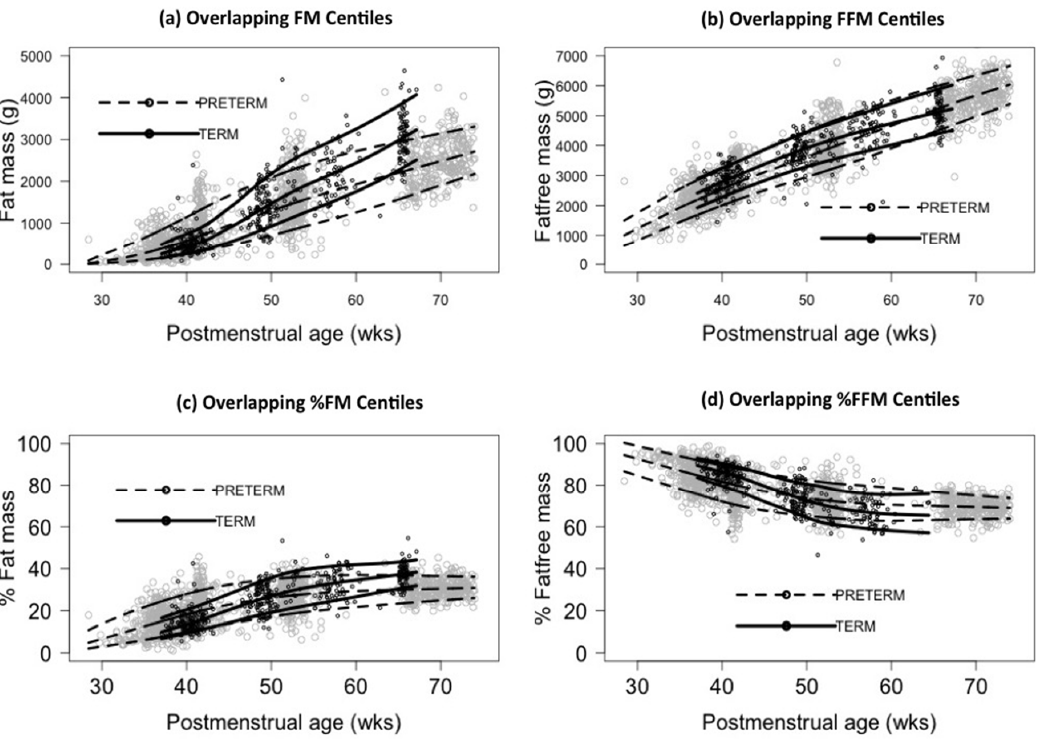
Figure 1. Overlapping 10th, 50th, and 90th centiles of FM and FFM in term and preterm infants. Preterm infants gained FFM faster than FM until corrected term. Beyond 50 weeks PMA, the rate of increase in FM was slower in preterms compared with terms. Preterm infants caught up with term FFM by 65 weeks PMA. ( c , d ) Overlapping 10th, 50th, and 90th centiles of %FM and %FFM over age in preterm and term infants. As age progressed, %FM increased, and %FFM decreased at the same rate. Until term equivalent, preterm infants had faster increases in %FM than term infants but subsequently slowed down and beyond 50 weeks, term infants had a faster increase until 6 months corrected age.